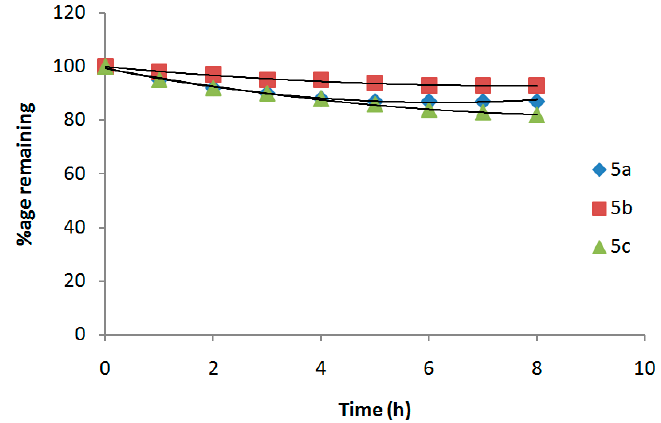
Figure 1. In vitro hydrolytic pattern of the ester prodrugs ( 5a – c ) in simulated intestinal fluid (SIF) (pH 7.4).